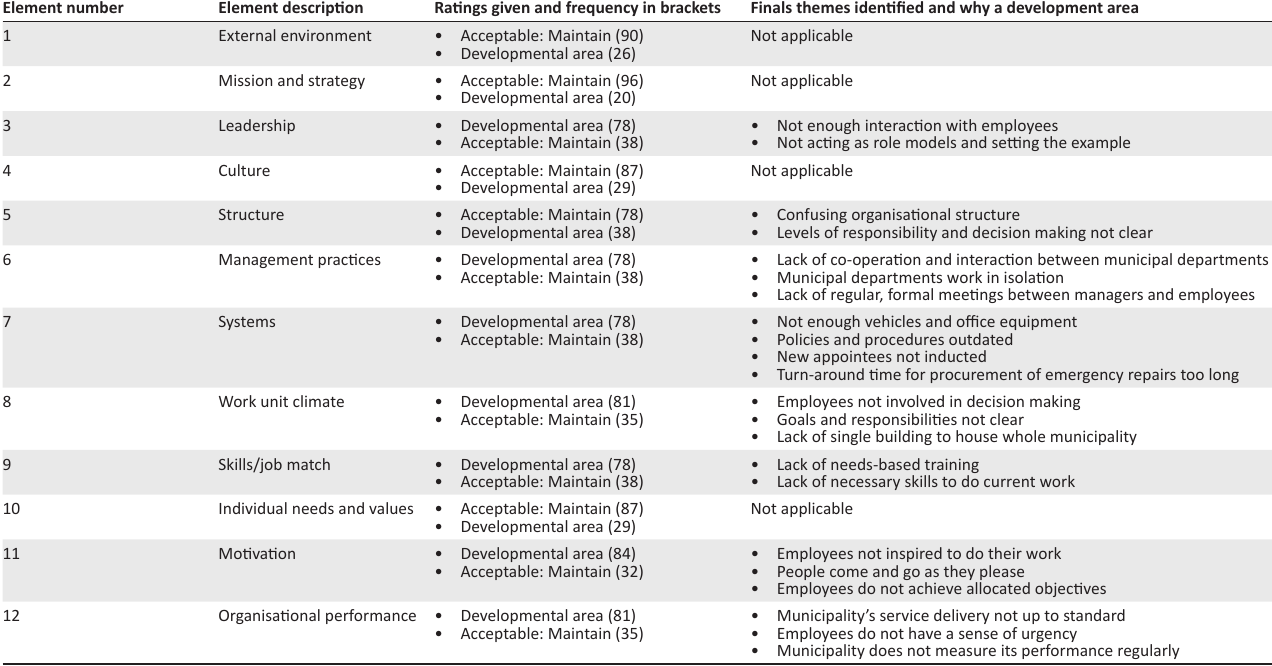
TABLE 4: Summary of the ratings by respondents for each Burke and Litwin element during the individual interviews and final themes identified from the interviews ( n = 116). Element number Element description